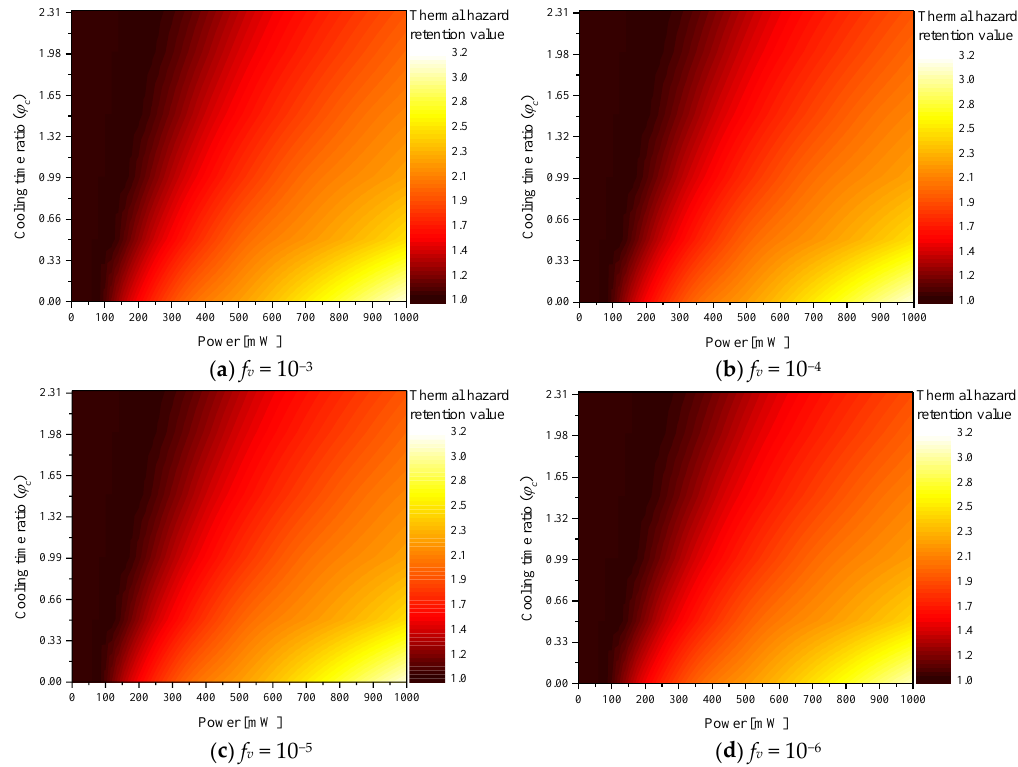
Figure 4. Thermal hazard retention value ( 𝜃 𝐻∗ ) for various cooling time ratios ( 𝜑 𝑐 ).